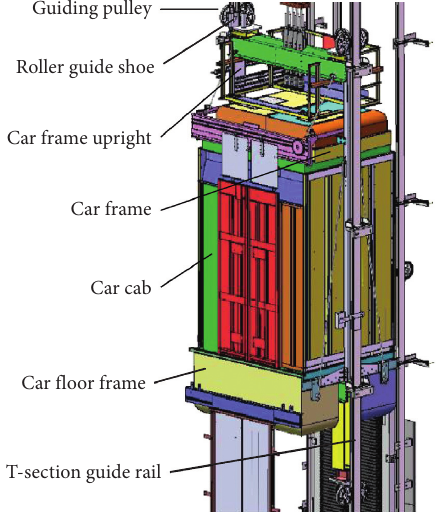
Figure 1: Composition of the HsEHV system.